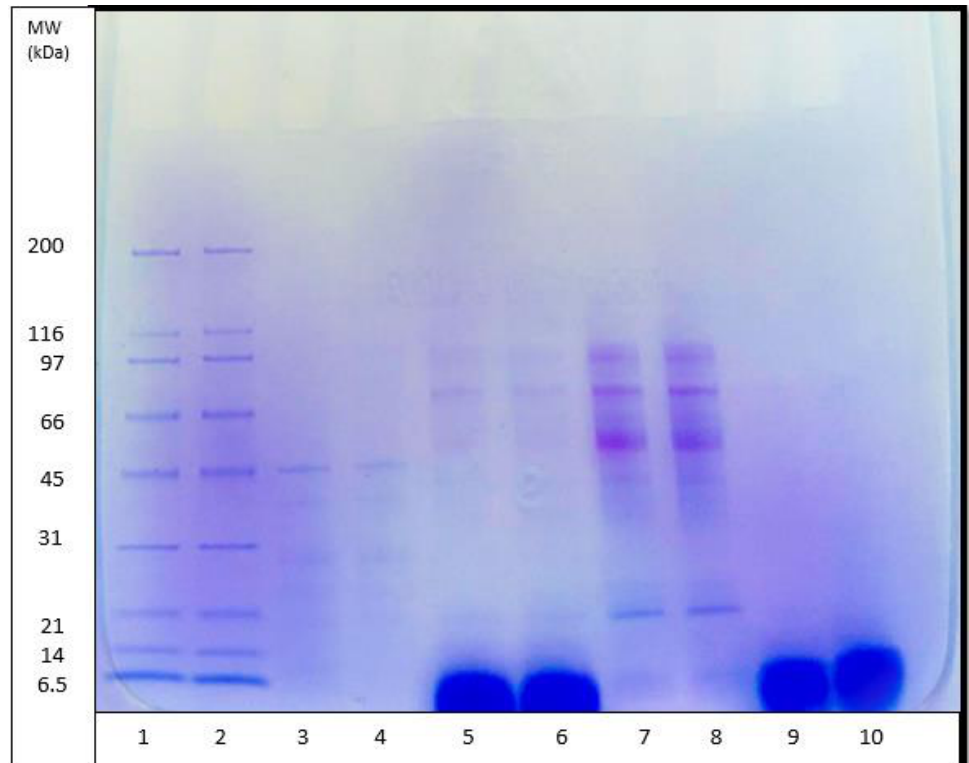
Figure 5. SDS polyacrylamide gel electrophoresis (SDS-PAGE) pattern of P. canaliculus proteins: lanes 1 and 2—broad-range standard protein marker (MW range of 200–6.5 kDa), lanes 3 and 4— unhydrolyzed green-lipped mussel protein, lanes 5 and 6—30 min pepsin hydrolysates, lanes 7 and 8—30 min alcalase hydrolysates, lanes 9 and 10—GPH-IV (protein fraction with the highest bioactivity).